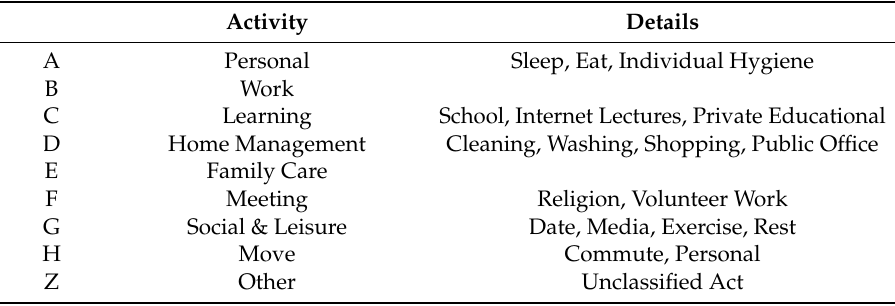
Table 2. Behavior codes of the Korean Time-Using Survey